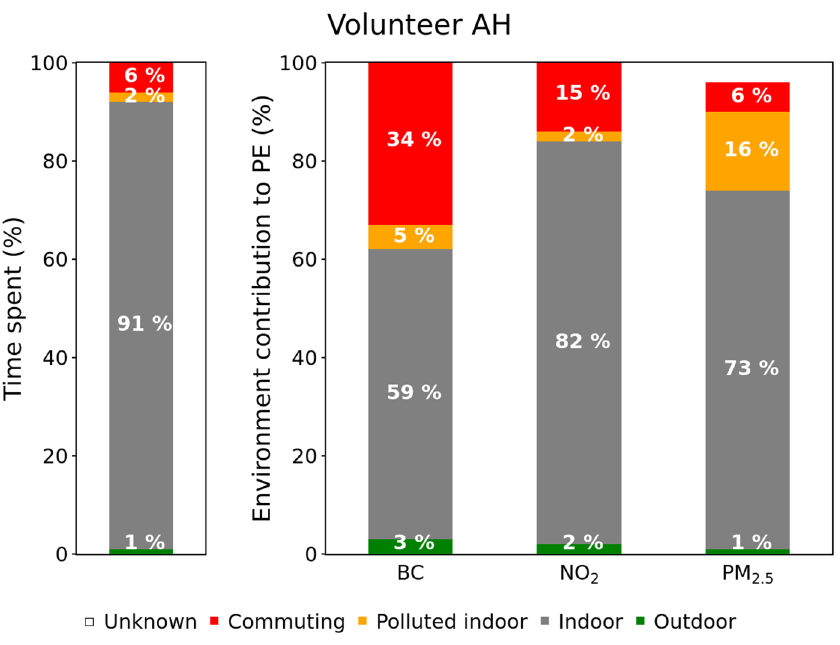
Figure 4. Time spent in each visited environment (left hand bar) and environment contribution to the total PE (volunteer AH, spring campaign).